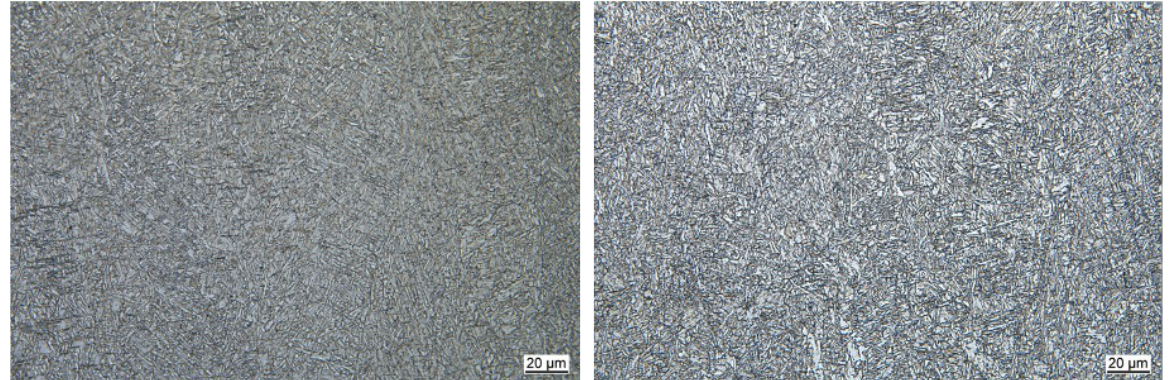
Figure 8. Microstructure morphology Mn4Ni2CrMo secondary metallurgy ( left ) alternative alloy ( right ) at 500× magnification.